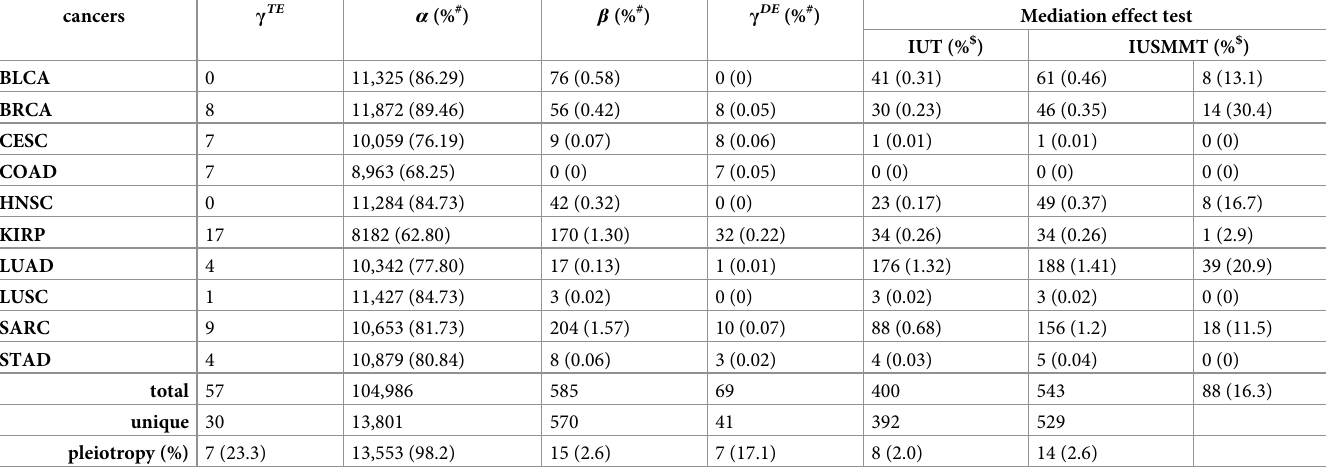
Table 2. Number of associated regions of DNA methylation CpG sites and genes identified in the survival mediation analysis. cancers